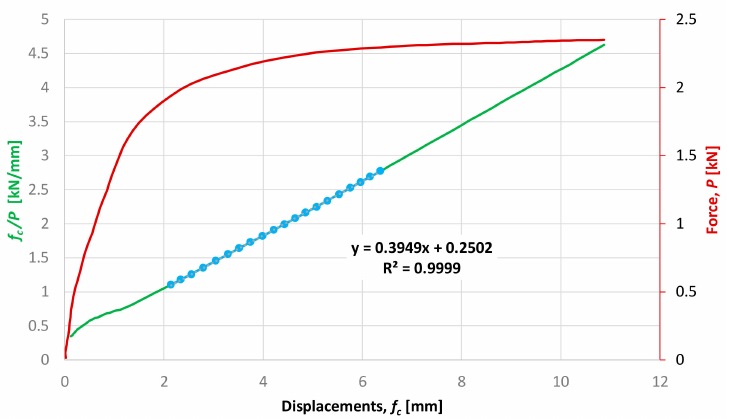
Figure 13. Specimen L = 915 mm. The initial part of the load deflection path and the Southwell’s plot.